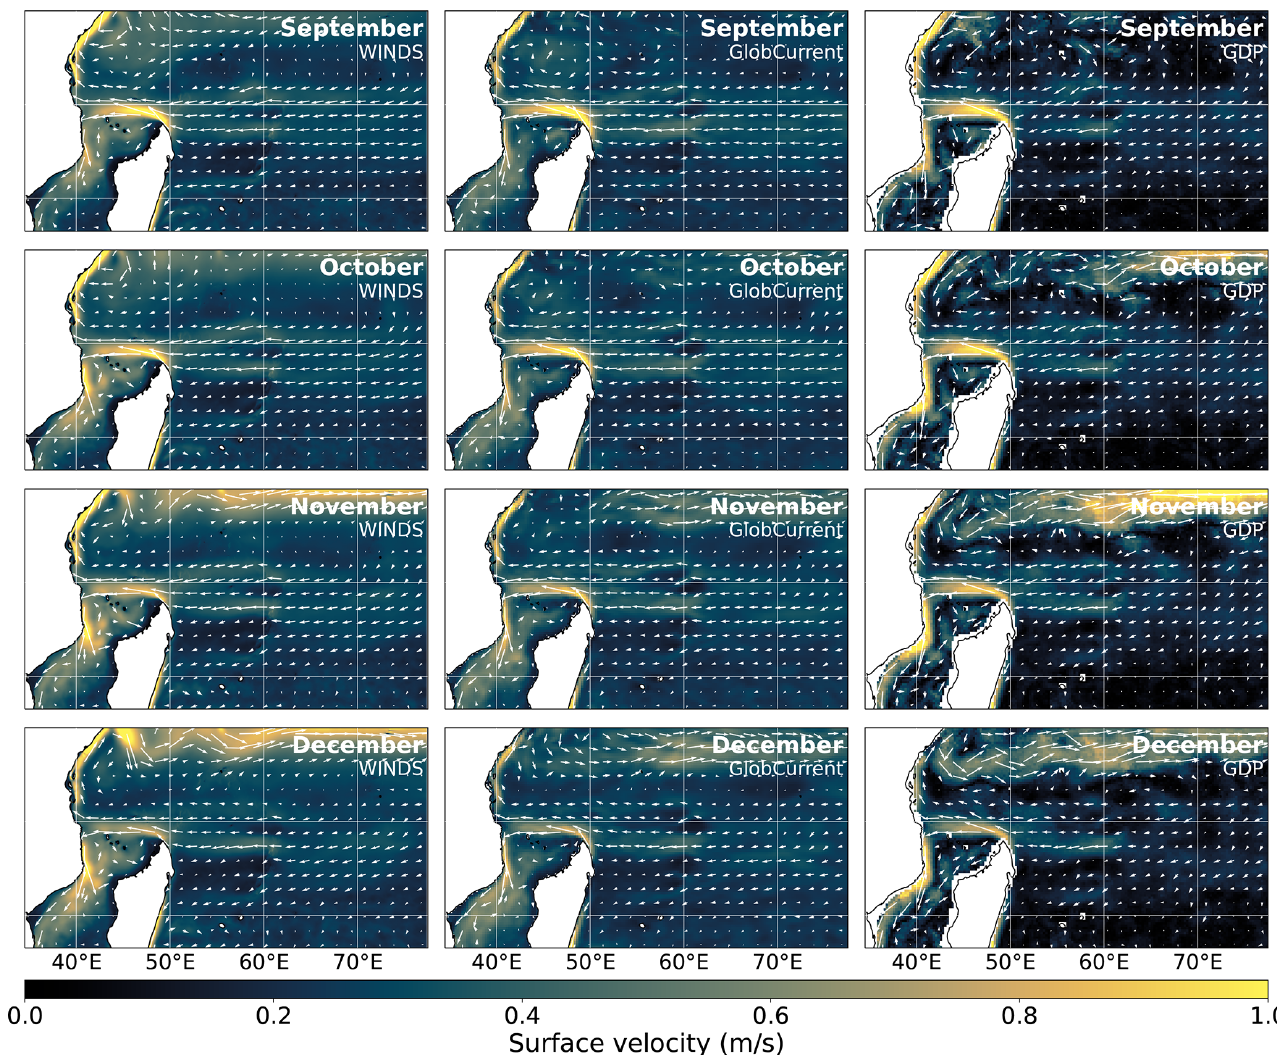
Figure 4. Monthly climatological surface currents (1993–2020) from WINDS (left), Copernicus GlobCurrent Surface (centre), and Global Drifter Program-derived near-surface currents (right) for September to